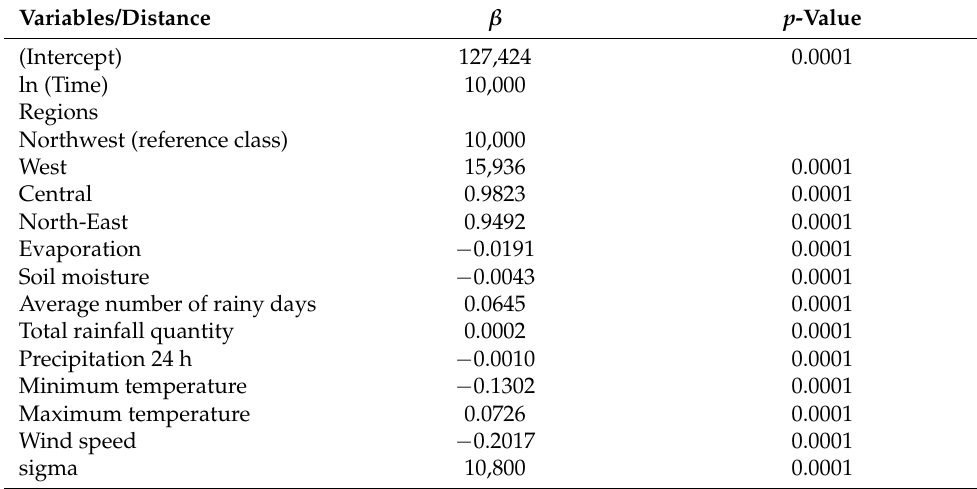
Table 4. Poisson Regression β coefficients by selected study characteristics.